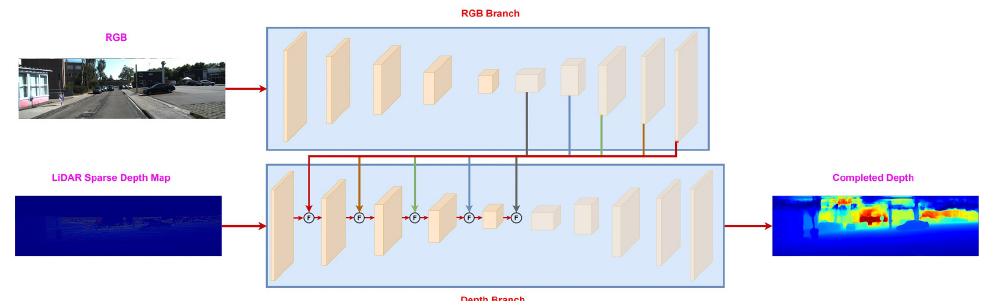
Figure 6. Deep Fusion between RGB image and LiDAR sparse depth map. Each modality is passed from a dedicated branch. The features from the decoder of the RGB branch are fused into the encoder of the depth branch. The symbol “F” represents the fusion operation. Common choices for fusion operation include addition or concatenation. However, complex fusion schemes can also be